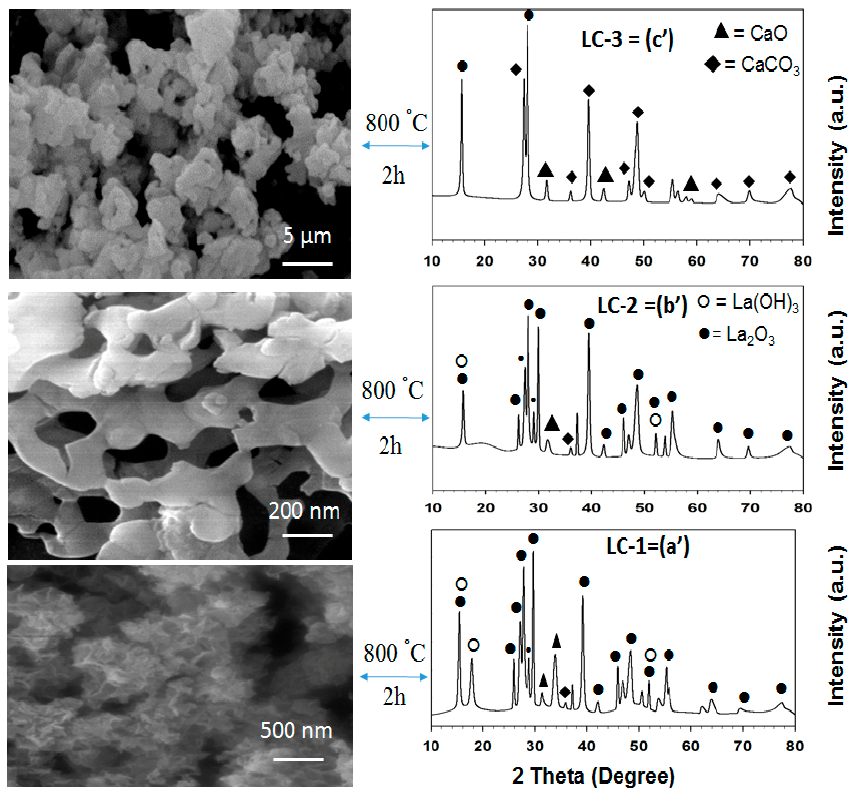
Figure 9. FESEM images of calcined samples (800 °C for 2 h) LC-1 (denoted as a ′ ), LC-2 (denoted as b ′ ), and LC-3 (denoted as c ′ ) and XRD patterns for the same samples.